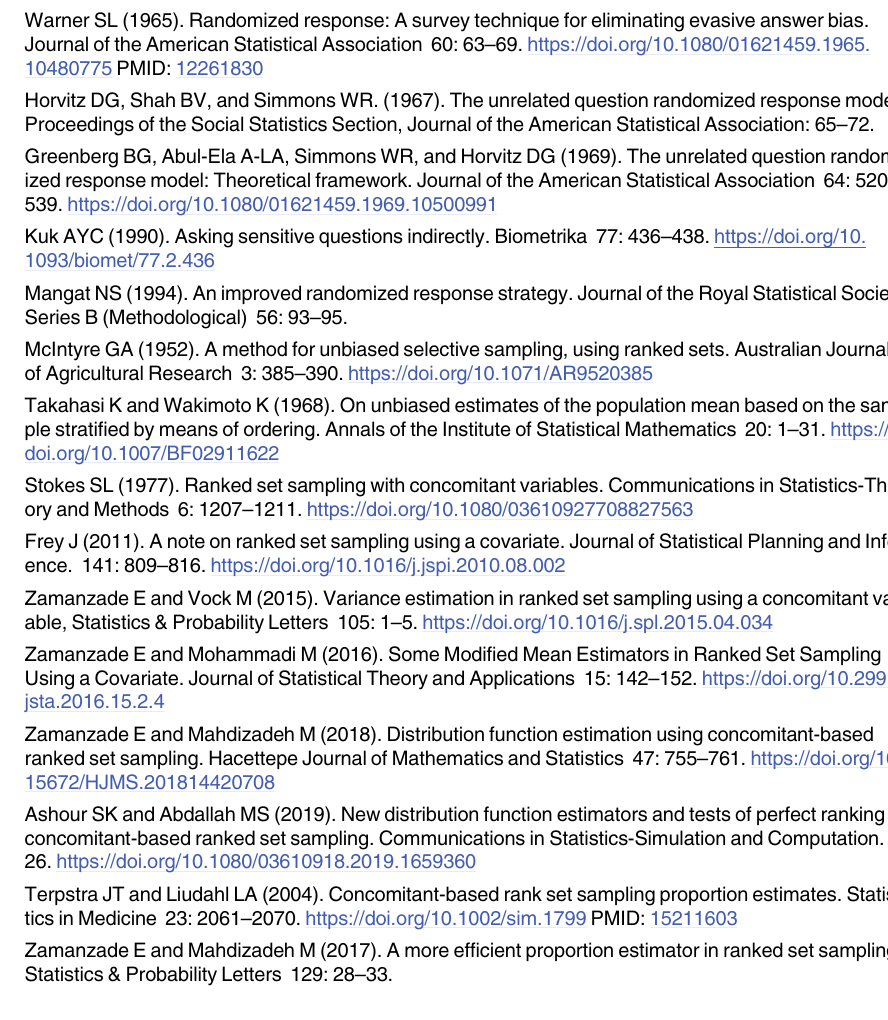
S1 Fig. Probability tree diagram of i th response. (TIF) S1 File. Relative efficiencies of the proposed methods and a layout of real data